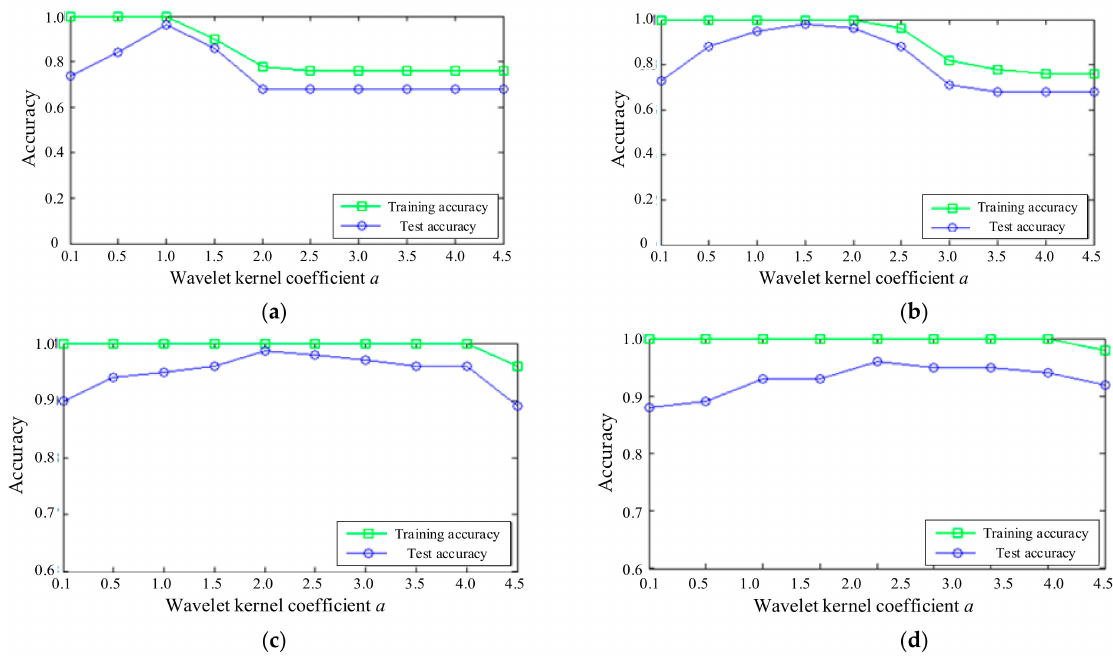
Figure 16. The influence of parameters on accuracy: ( a ) C = 10; ( b ) C = 100; ( c ) C = 1000; and ( d ) C =